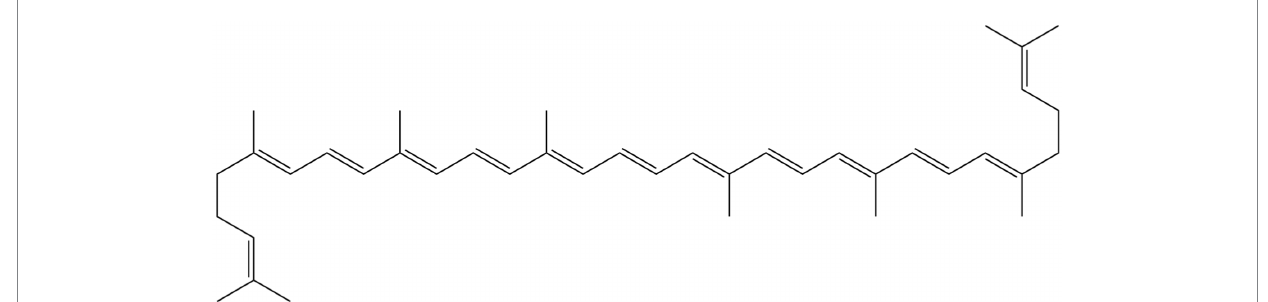
FIGURE 15 Chemical structure of lycopene.